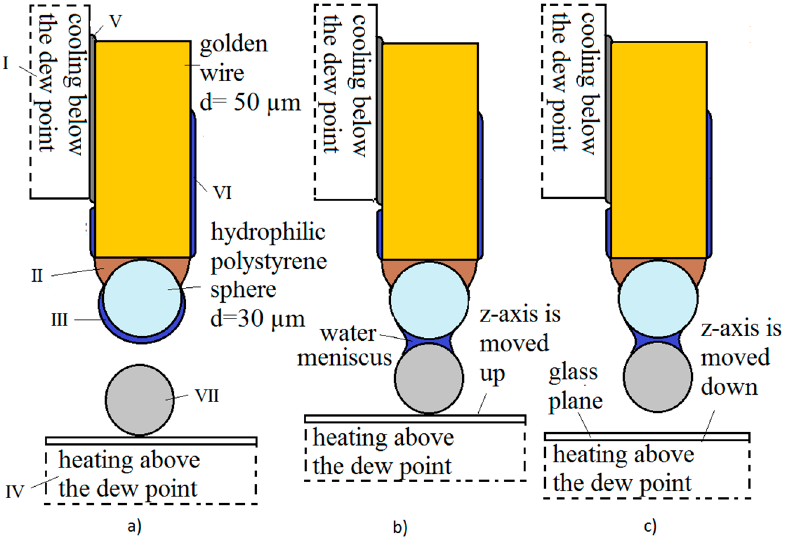
Figure 2. Gripping procedure using the capillary force method based on a thin layer of condensed water: ( a ) a thin layer of water was created on the tip; ( b ) a water meniscus was created between the tip and the object; ( c ) the object gripped to the tip. (I—Peltier element x -axis; II—hydrophobic epoxy adhesive; III—condensed layer of water; IV—Peltier element z -axis; V—heat conducting paste; VI—thin layer of condensed water; VII—spherical micro object, d = 5–60